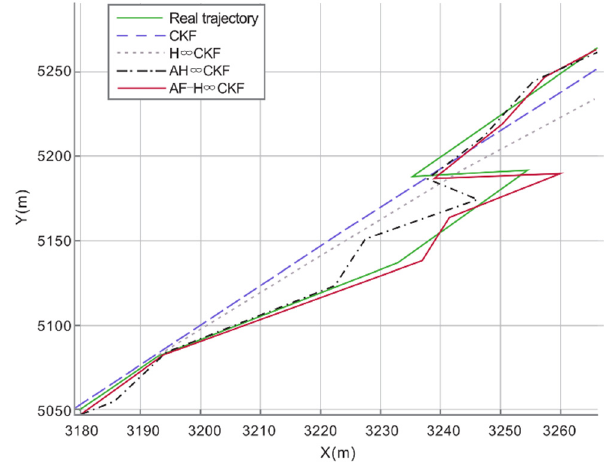
Figure 5. Partial enlargement of Figure 4.